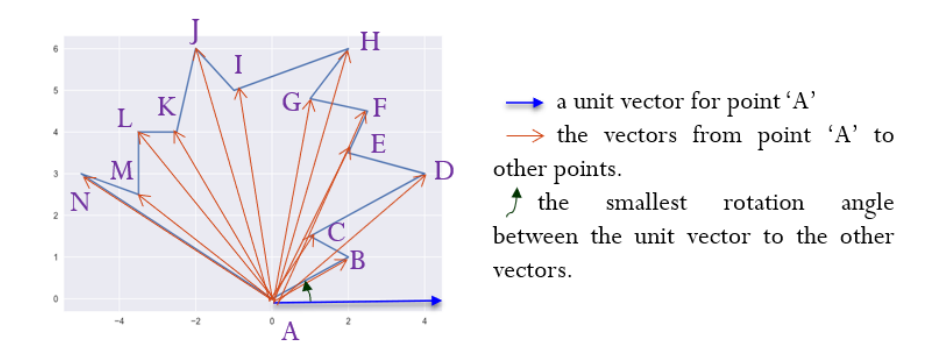
Figure 2. Vector representation for point “A” of the VRAOA